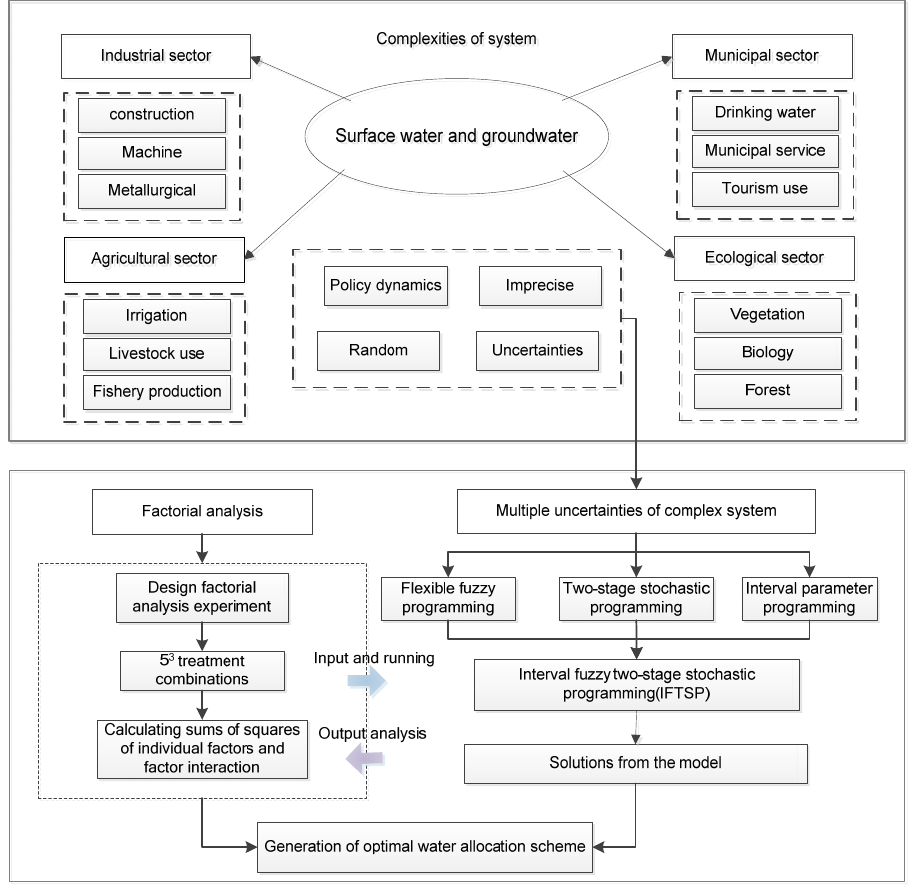
Figure 1. The framework of this